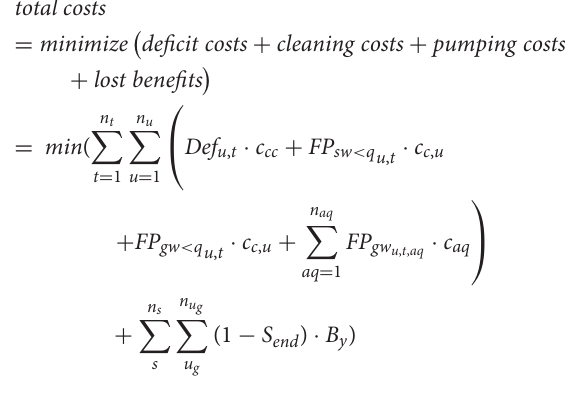
the 16 sub-basins represented by the model, water demands were Water